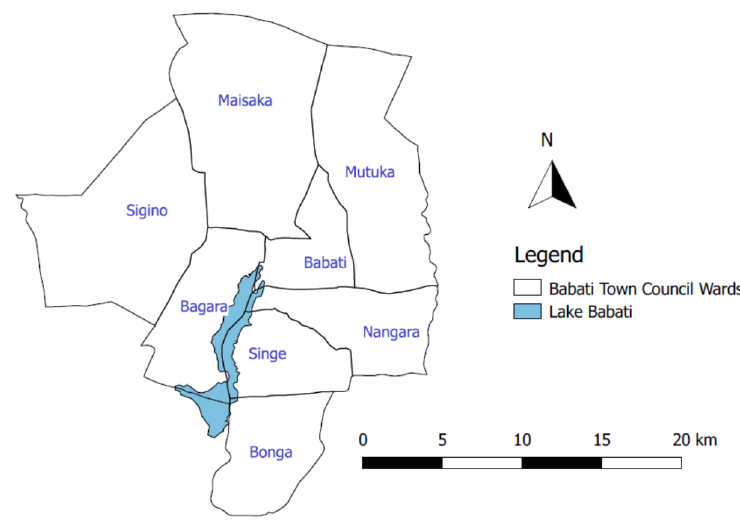
Figure 2. Babati Town Council administrative boundary.